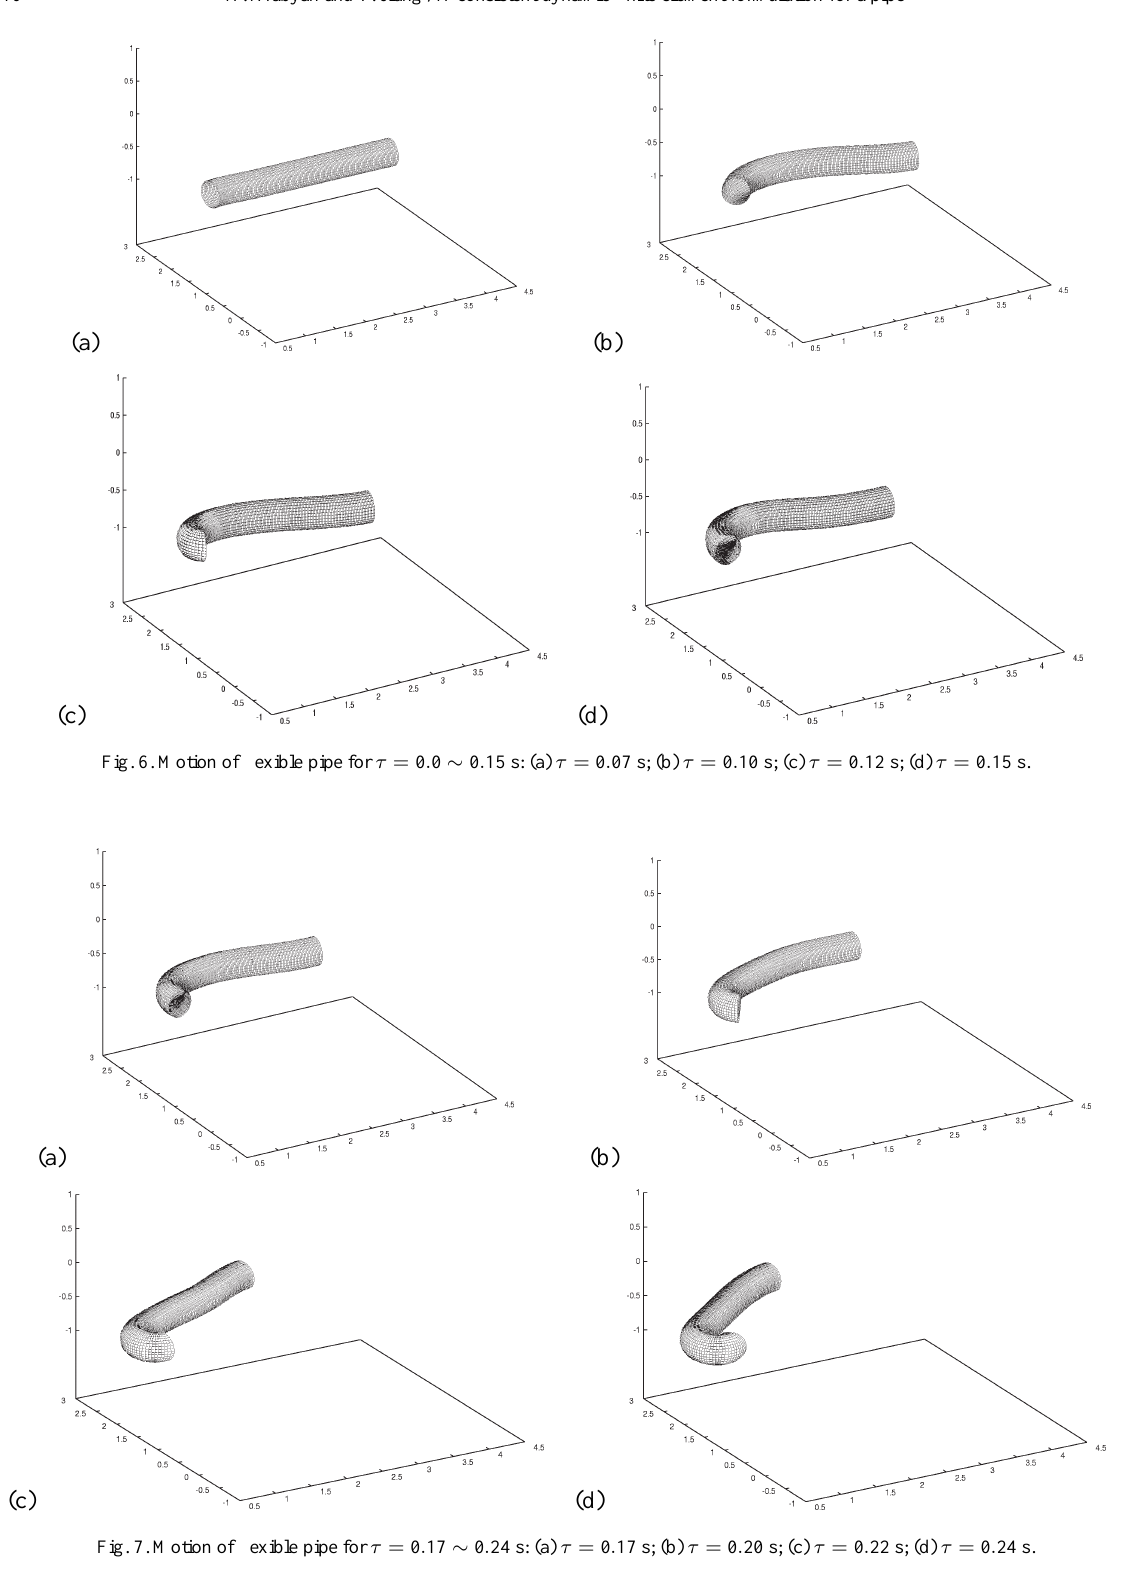
Fig. 7. Motion of flexible pipe for (cid:28) = 0 : 17 (cid:24) 0 : 24 s: (a) (cid:28) = 0 : 17 s; (b) (cid:28) = 0 : 20 s; (c) (cid:28) = 0 : 22 s; (d) (cid:28) = 0 : 24